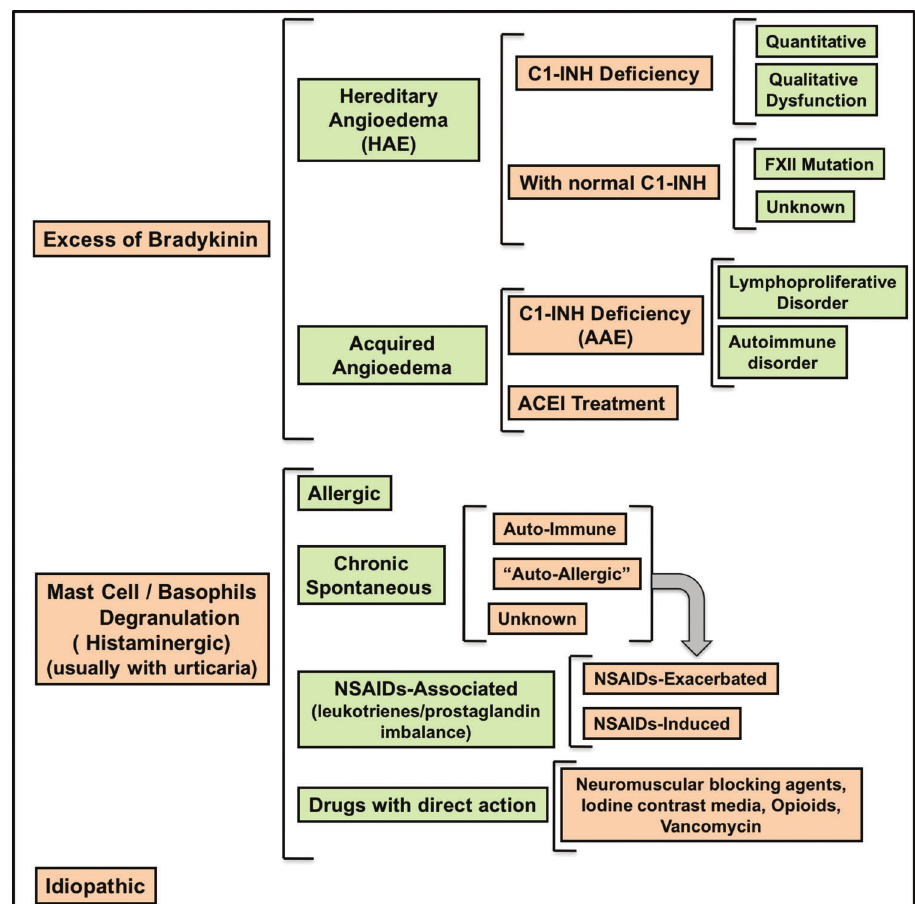
Figure 4 - Classification of Angioedema by Endotypes